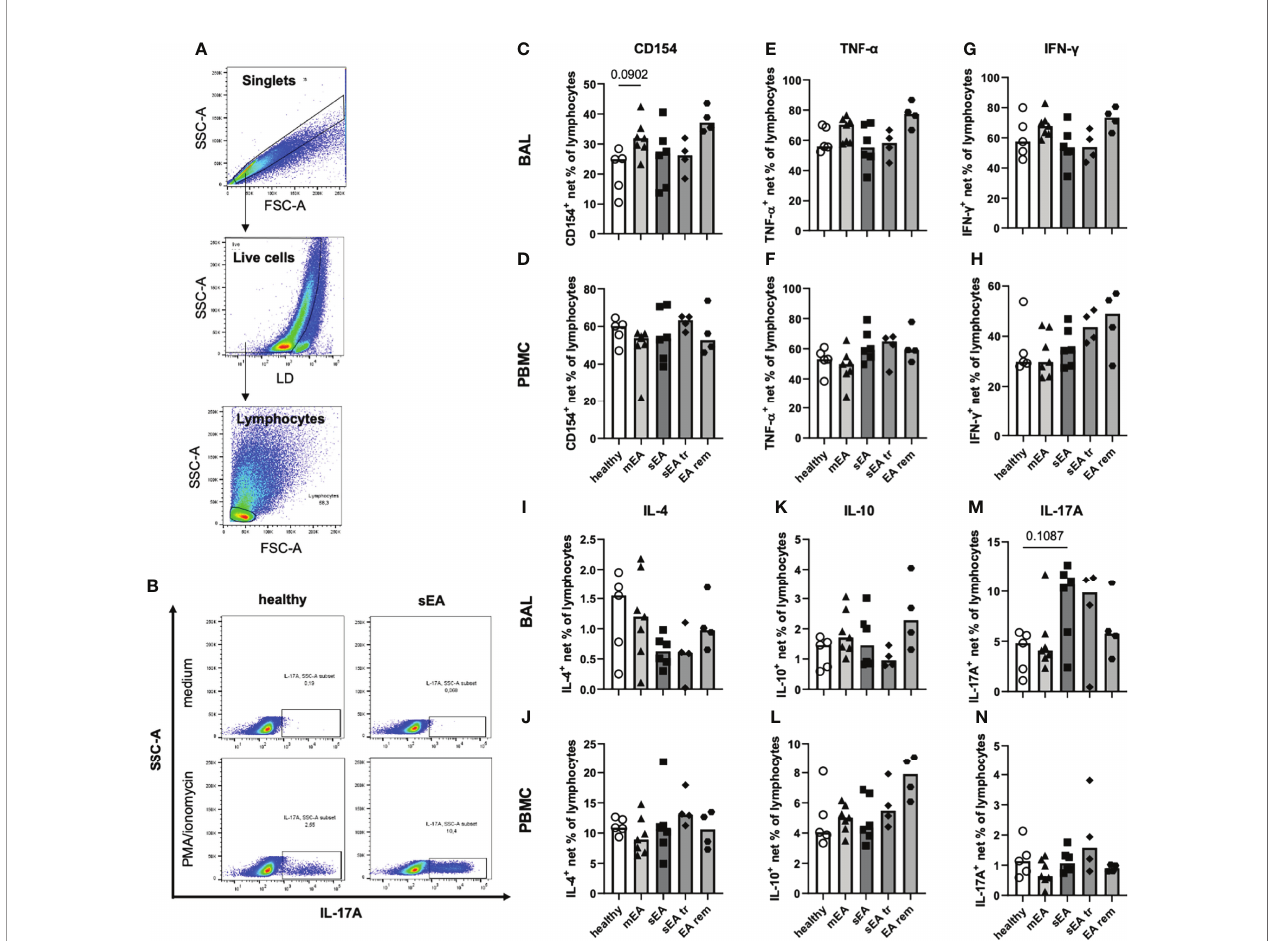
FIGURE 6 | In vitro stimulation of equine BAL lymphocytes induces expression of several cytokines with a bias toward increased IL-17A expression in sEA. Representative plots show the gating of (A) singlet live lymphocytes in BAL from one horse with sEA. (B) Representative plots of cytokine-expressing BAL lymphocytes (IL-17A) of one healthy and one asthmatic (sEA) horse after in vitro incubation in medium alone or stimulation with PMA/ionomycin are shown. Medium- corrected net percentages of CD154- or cytokine-expressing lymphocytes are displayed for BAL cells (C, E, G, I, K, M) and PBMC (D, F, H, J, L, N) . Results of individual horses (total n=26) are shown with bars indicating median values (n=4 – 7 per group). Expression of CD154 and cytokines was not signi fi cantly different in BAL cells or PBMC between horses from different groups. Trends are indicated by given p-values (p<0.12 in Kruskal-Wallis tests comparing groups with n ≥ 5: healthy, mEA, sEA). In BAL lymphocytes there were trends of (C) higher CD154 + frequencies in BAL lymphocytes from horses with mEA, and M ) higher IL-17A + frequencies in BAL lymphocytes from sEA, compared to healthy